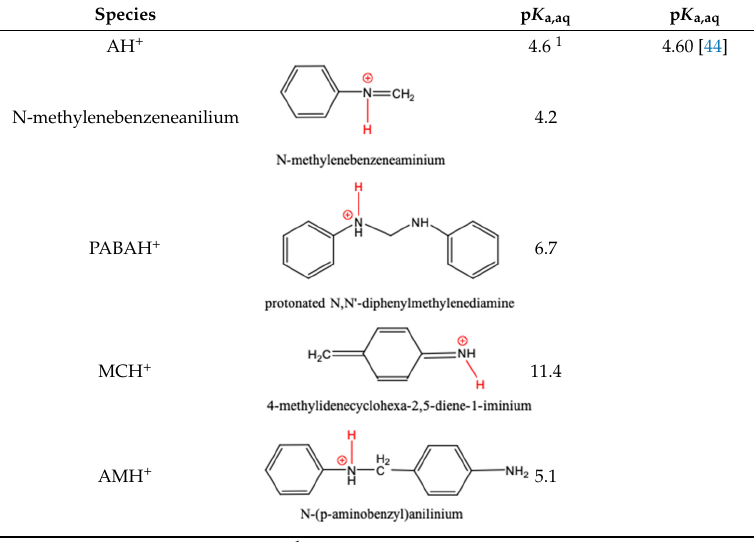
Table 4. Thermochemical properties for some side reactions of the formation of 4,4’-MDAH + .